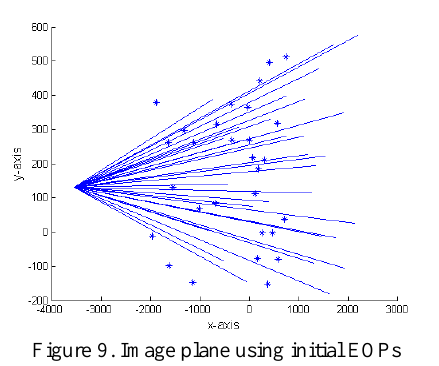
Figure 9. Image plane using initial EOPs